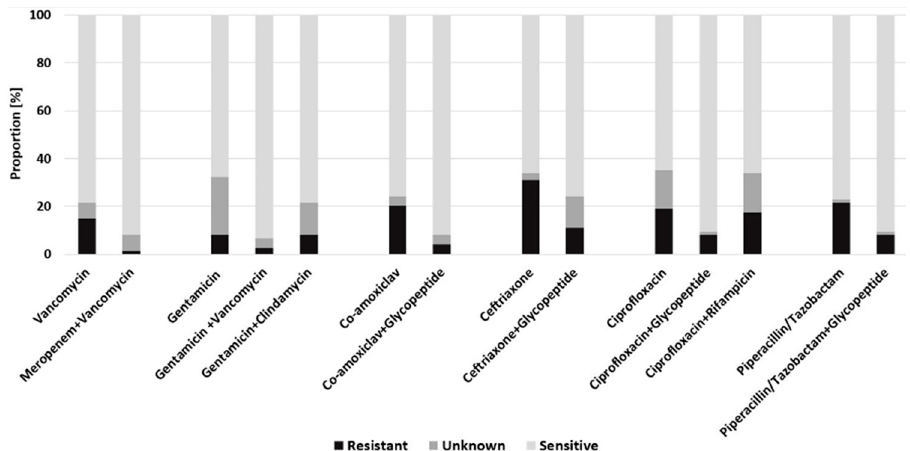
Figure 3. Predicted efficacy of empiric antimicrobial regimens for the FRI cohort.